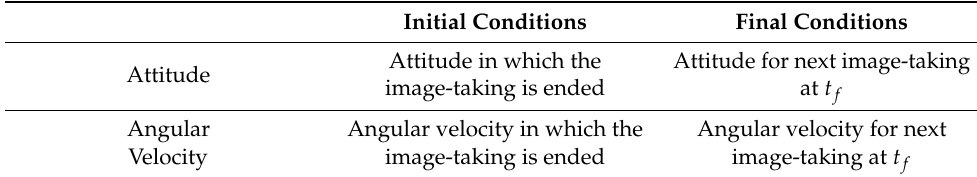
Table 1. Boundary conditions for retargeting